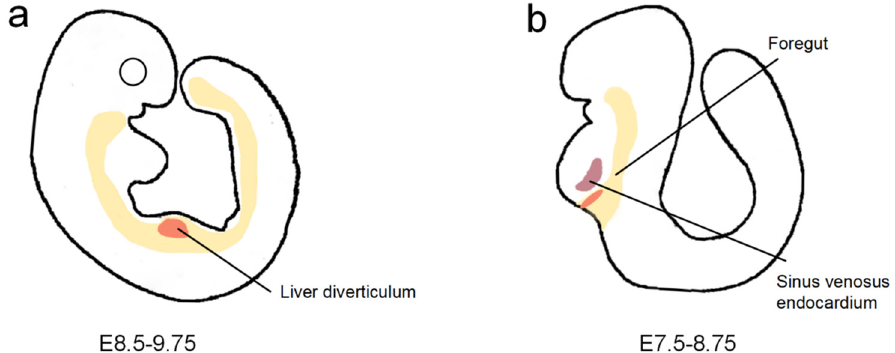
Figure 1. The origin of hepatic endothelial cells. ( a ) At E9.5, the liver diverticulum is surrounded by the omphalomesenteric veins, posterior cardinal veins, or common cardinal veins. ( b ) At E8.5, the liver at budding stage is located in the portion of the ventral foregut endoderm, which is adjacent to the sinus venosus endocardium.